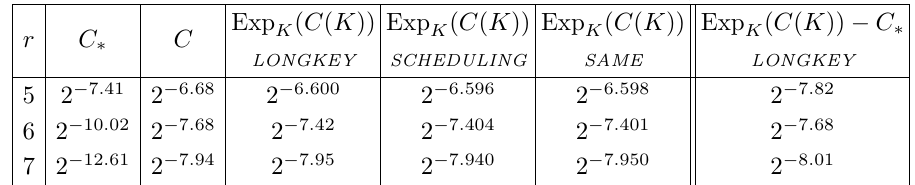
Table 2: The expected value of the capacity